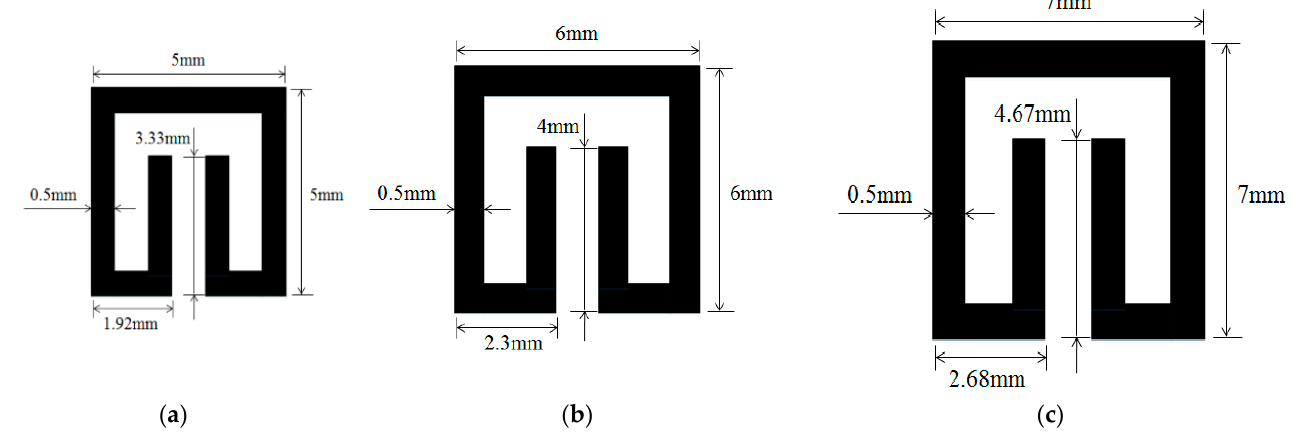
Figure 3. Dimensions of three tested split-ring resonators. ( a ) SRR1, ( b ) SRR2, ( c ) SRR3.